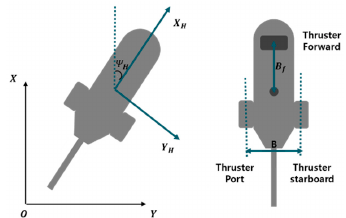
Figure 6. Conceptual diagram and coordinate system of the UUV.